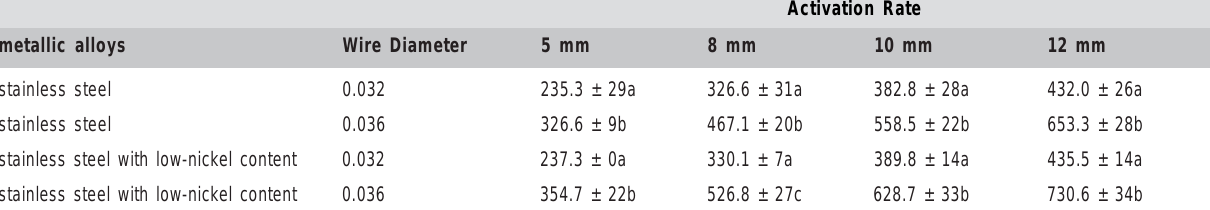
Table 1. Mean forces (g) produced by the Coffin Appliance.